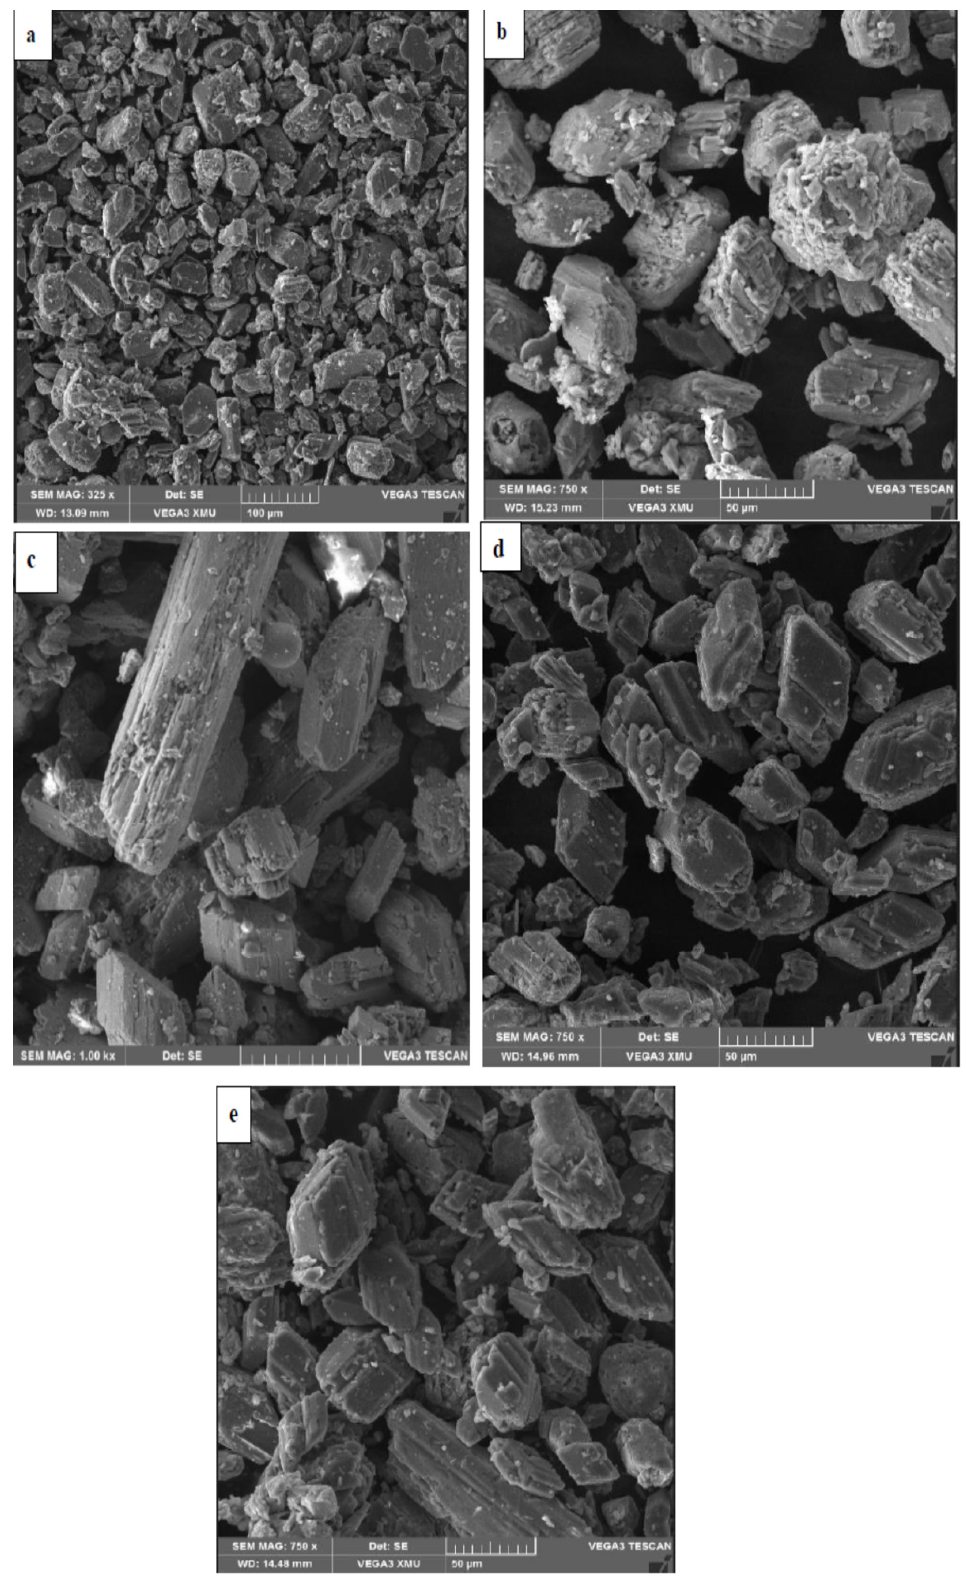
Figure 10. SEM analysis of WFGD gypsum cured at ambient temperature (( a ) 7 days, ( b ) 21 days, ( c ) 28 days, ( d ) 56 days and ( e ) 90 days).